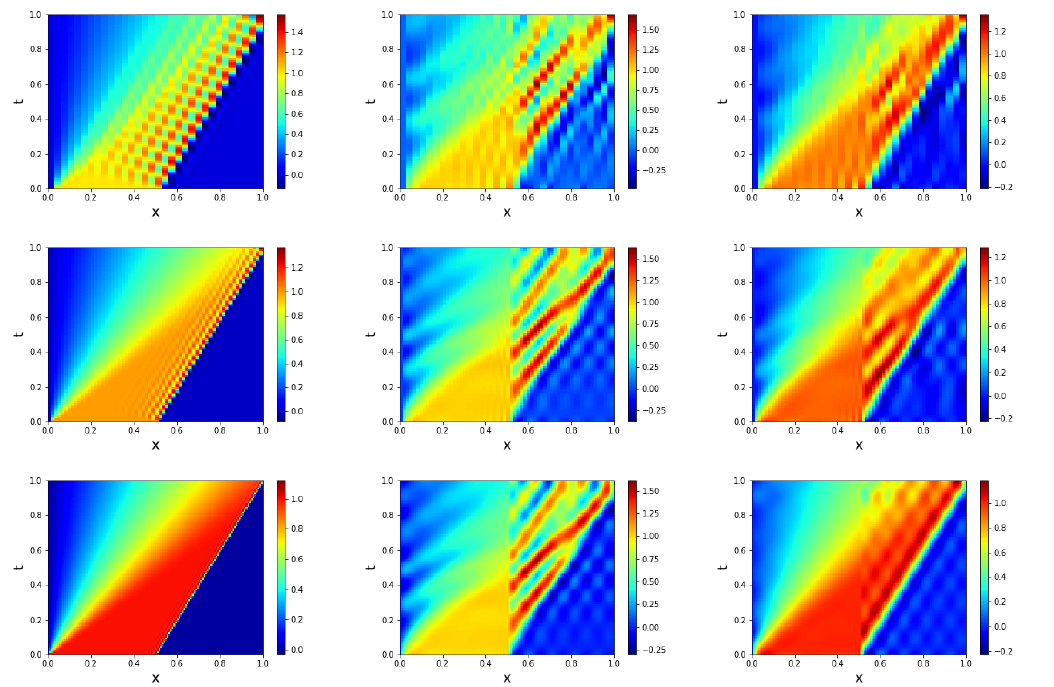
Figure 8. Reconstructive regime, Re = 1000: FOM ( first column ), GP-ROM ( second column ), and ResNet-ROM ( third column ), for meshsizes h = 1/64 ( first row ), h = 1/128 ( second row ), and h = 1/256 ( third row ). ResNet-ROM yields the most accurate